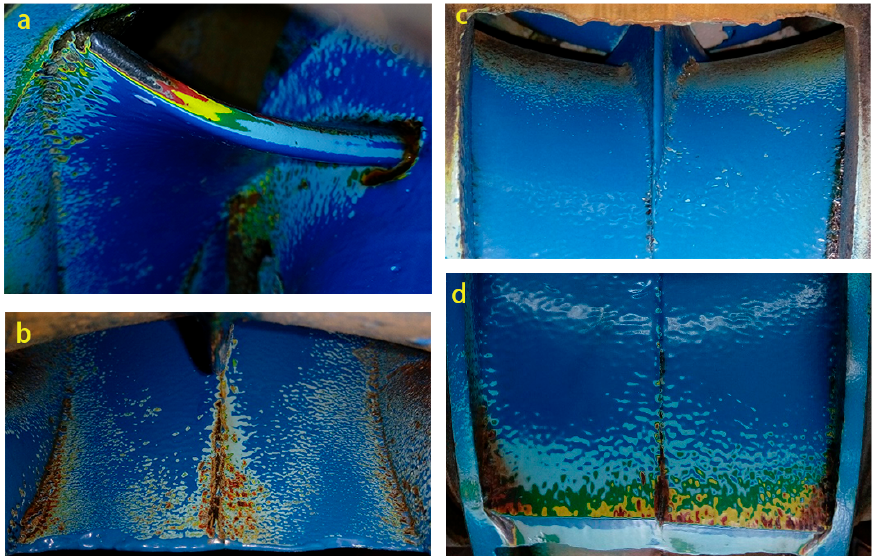
Figure 6. Silt erosion of painted impeller. ( a ) blade inlet; ( b ) suction side; ( c ) inlet section of the pressure side; ( d ) outlet section of the pressure side.